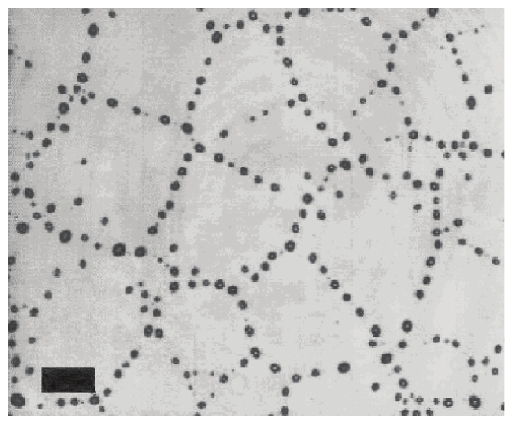
Figure 1: Shows micrograph of final polygon pattern after decay of rims into droplets. The initial sample was a 45 nm thick PS film on wafer A. The length of the bar is 70 μ m. Sharma and Reiter [26].